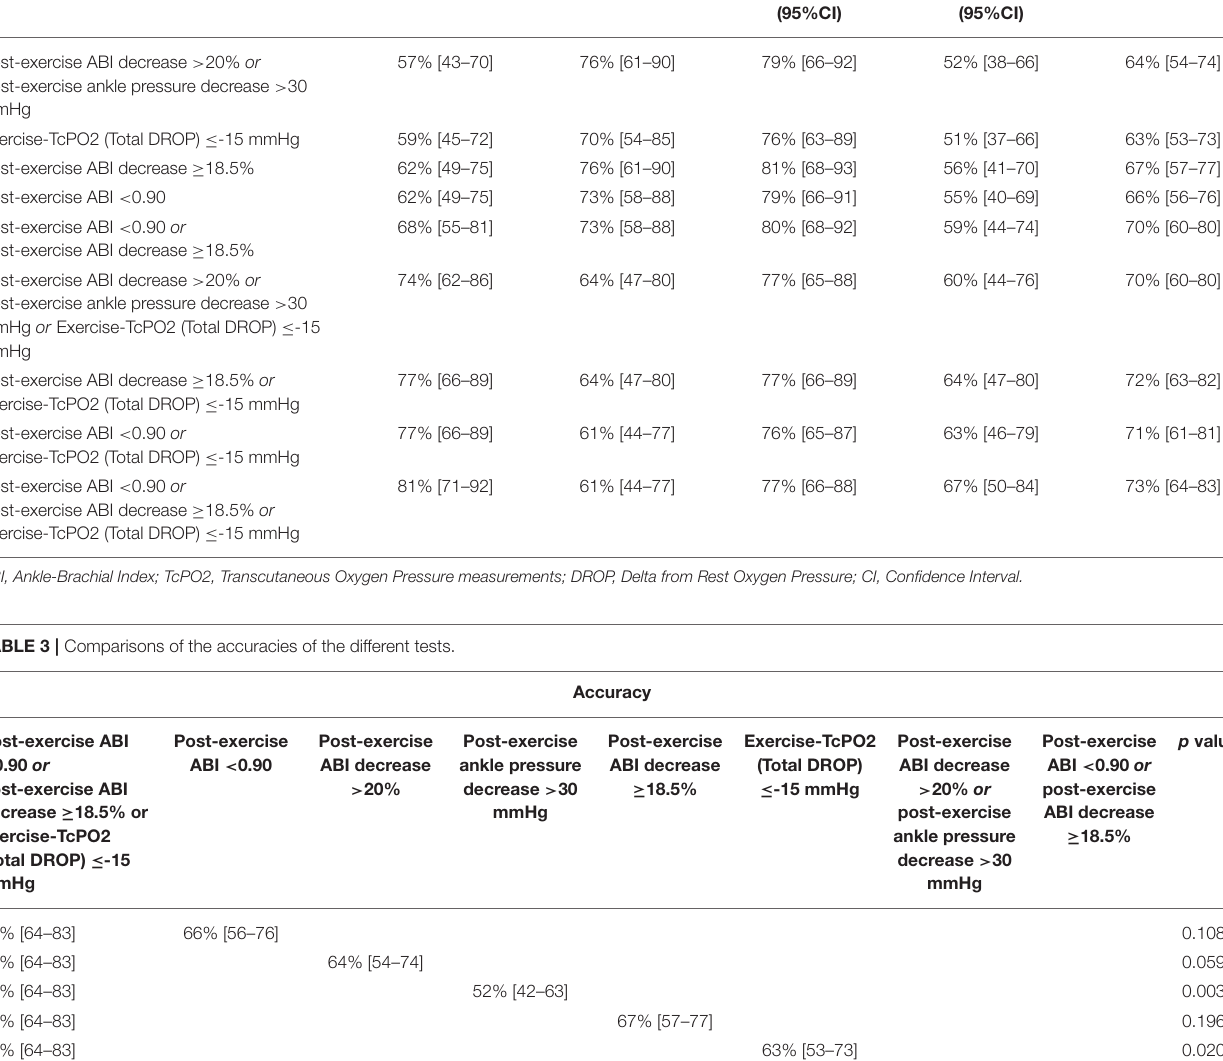
TABLE 2 | Diagnosis performances of the different exercise criteria to diagnose lower extremity peripheral artery disease. Population (n = 56) Limbs with a resting-ABI > 0.90 (n = 86)